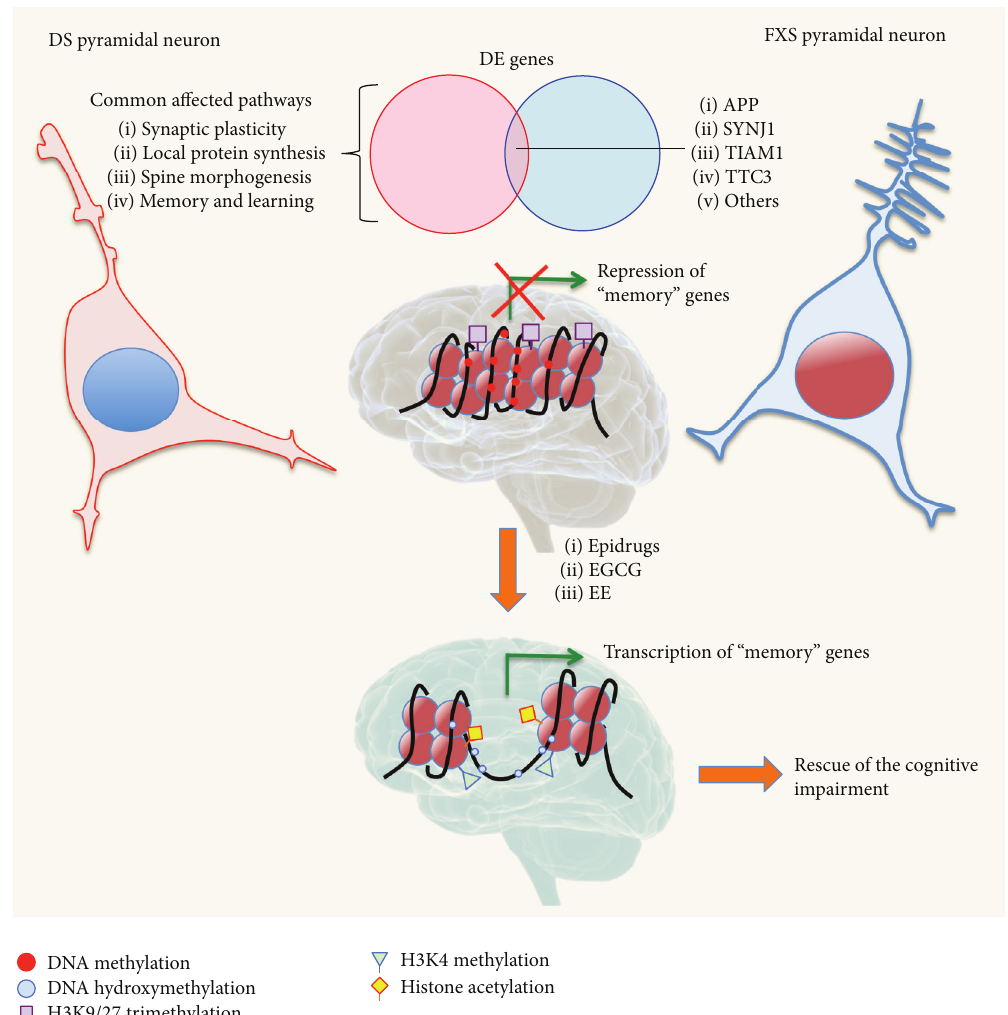
Figure 4: Reestablishing a balanced epigenetic state to rescue the cognitive impairment in Down Syndrome (DS) and Fragile X Syndrome (FXS). Cartoon representation of a DS (left) and FXS (right) pyramidal neuron. In both syndromes alterations in synaptic plasticity, local protein synthesis, spine morphogenesis, and memory and learning contribute to the cognitive impairment. However the structural phenotype is distinct: DS neurons have large and stubby spines, while FXS neurons have long immature filopodia-like spines. Key genes involved in these pathways (e.g., APP, SYNJ1, TIAM1, and TTC3)are commonly deregulated due to epigenetic modifications at the chromatin level. The cartoon shows the repression of “memory” genes by DNA methylation (red circles) and H3K9 and H3K27 trimethylation (violet squares) in DS and FXS, with consequent chromatin compaction. Conversely, epigallocatechin gallate (EGCG) and Environmental Enrichment (EE) or directly epidrugs can reactivate the chromatin state at the level of “memory” gene by DNA hydroxymethylation (blue circles), H3K4 methylation (green triangles), and histone acetylation (yellow squares), rescuing the cognitive